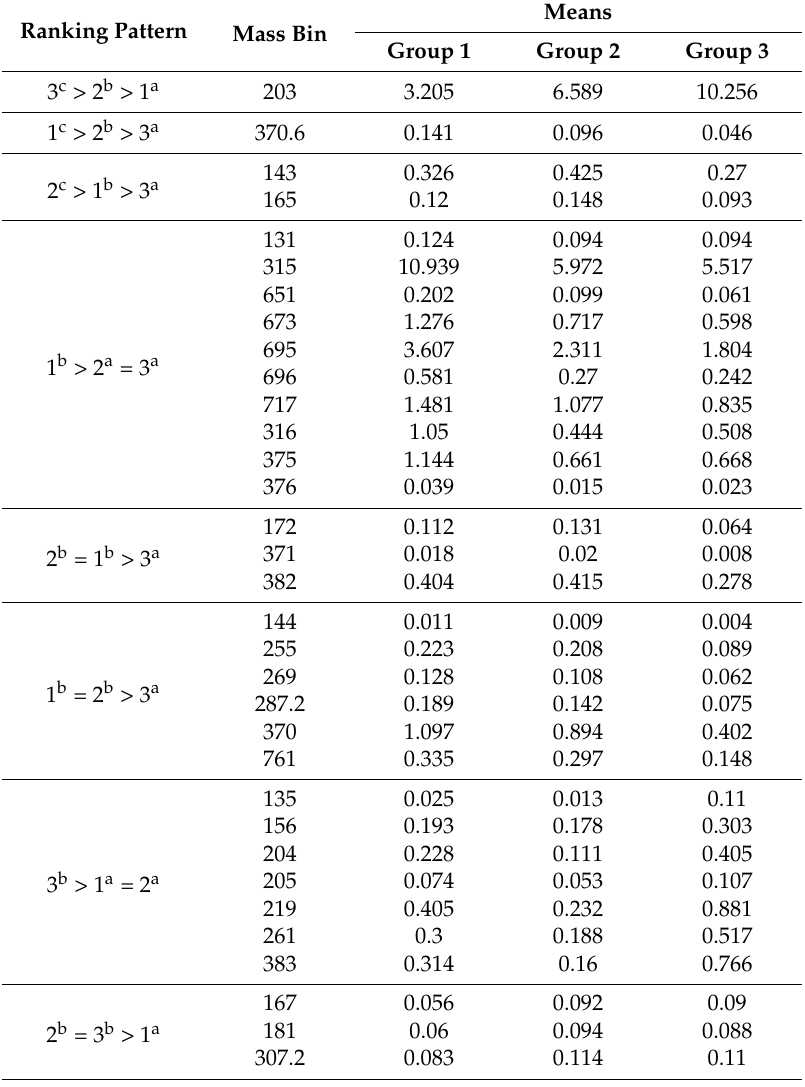
Table 2. Influential mass bins showing significant differences between quality groups in